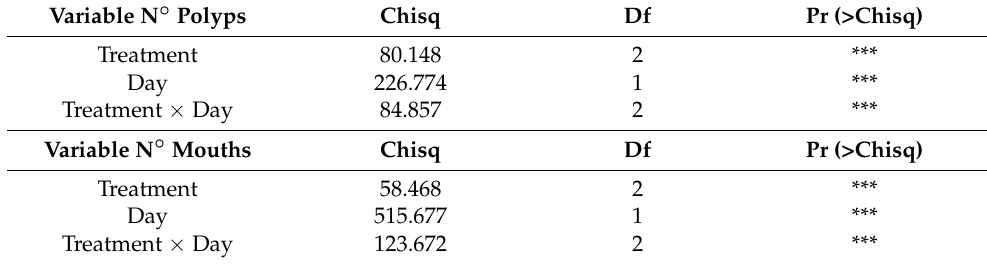
Table 2. Quasi-Poisson Generalized Linear Mixed Models (GLMM) and statistical significance of the fixed effects in explaining the variation of the number of polyps and the number of mouths. Both the main explanatory terms and their interaction resulted highly significant in the models. R 2 ( N ◦ of Polyps ) = 0.91. *** p < 0.001, R 2 ( N ◦ of Mouths ) = 0.94. Chisq = X 2 , Df = degrees of freedom. *** p <